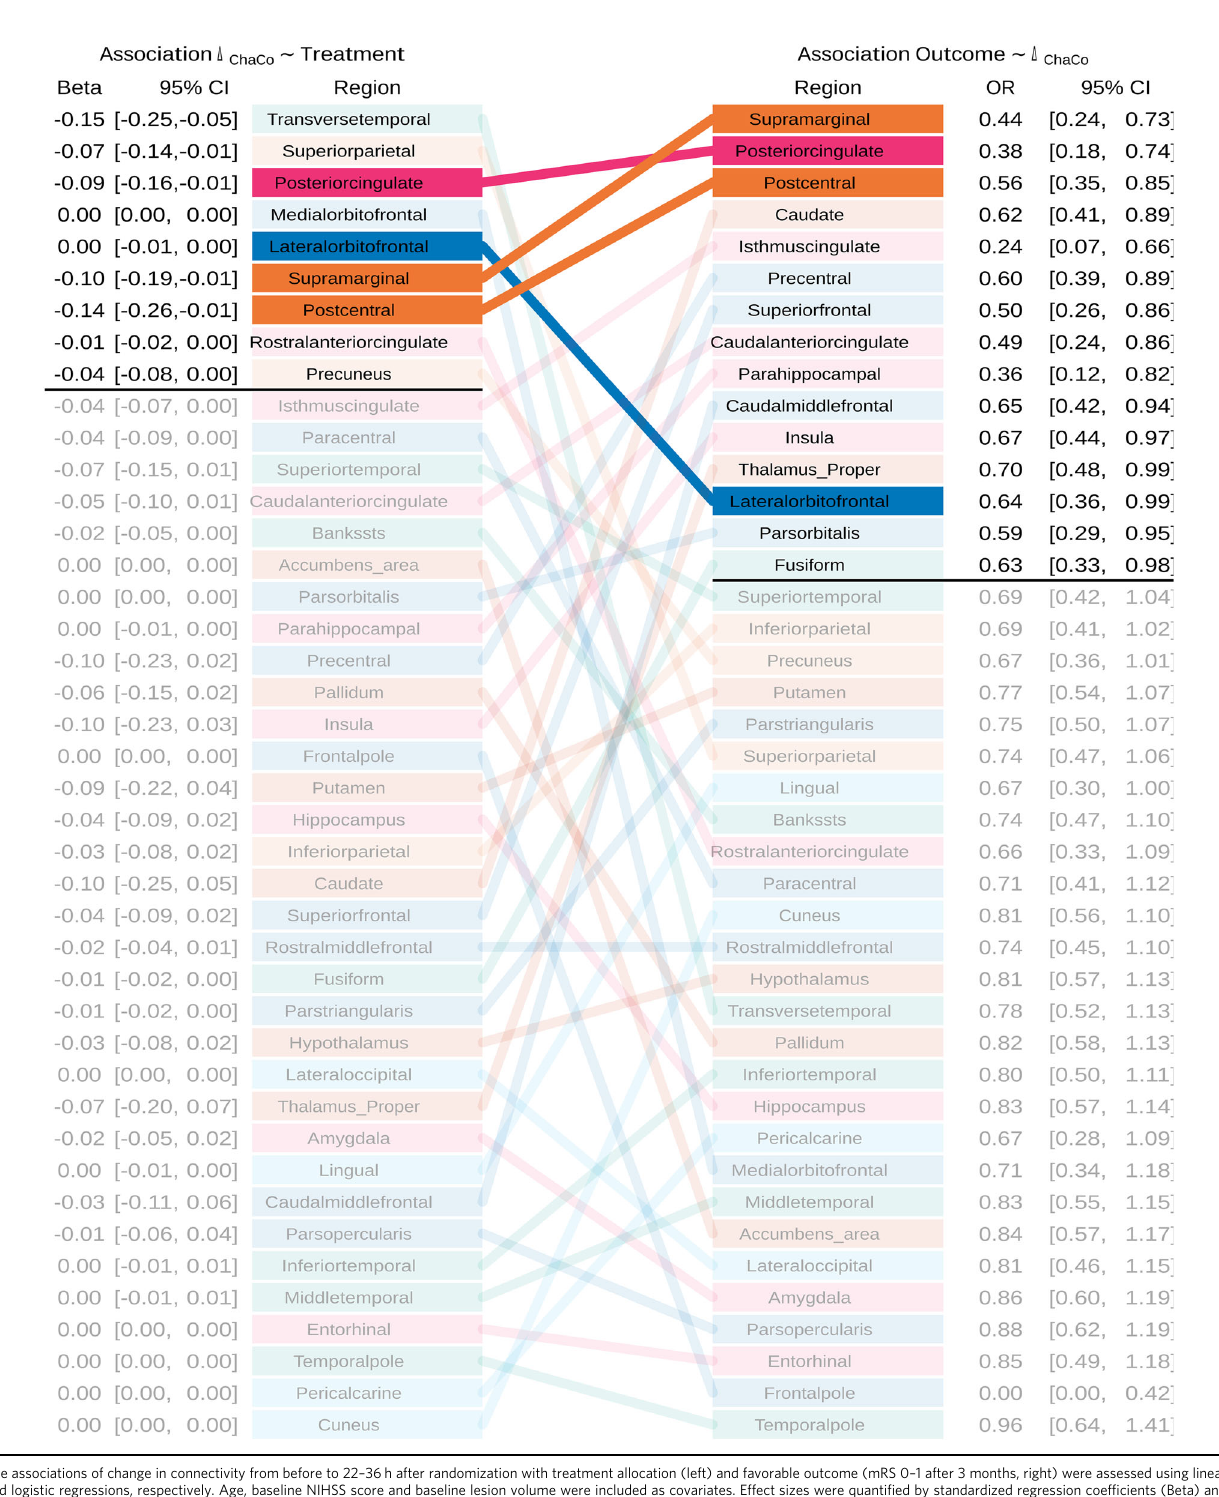
Table 2 Selection of brain regions for multiple mediation